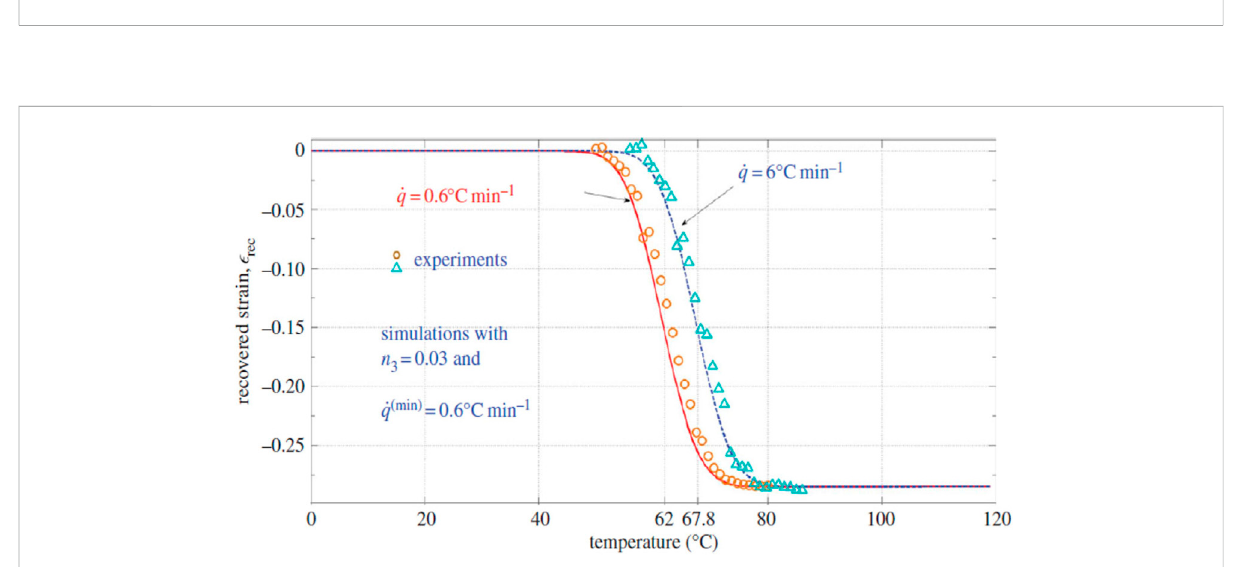
FIGURE 17 Dependence of the shape recovery process on the heating rate (Shojaei and Li, 2014). [Reproduced with permission from Proceedings of the Royal Society A, 470: 20140199., (2014). Copyright 2014 Royal